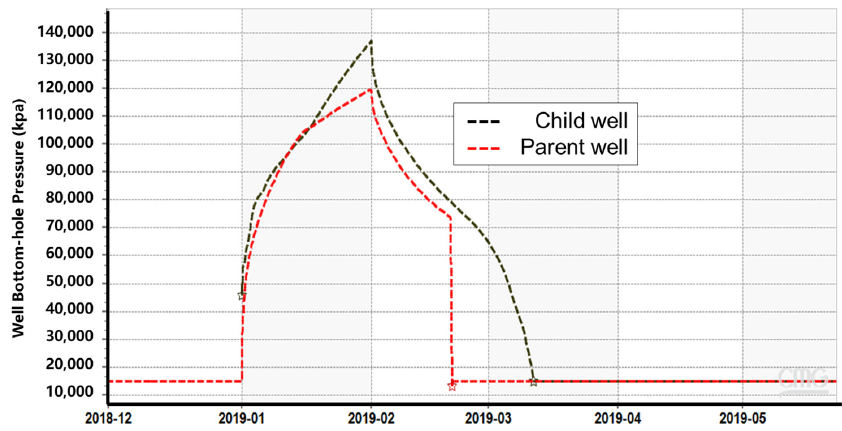
Figure 16. Well bottom-hole pressure of parent well and child well.